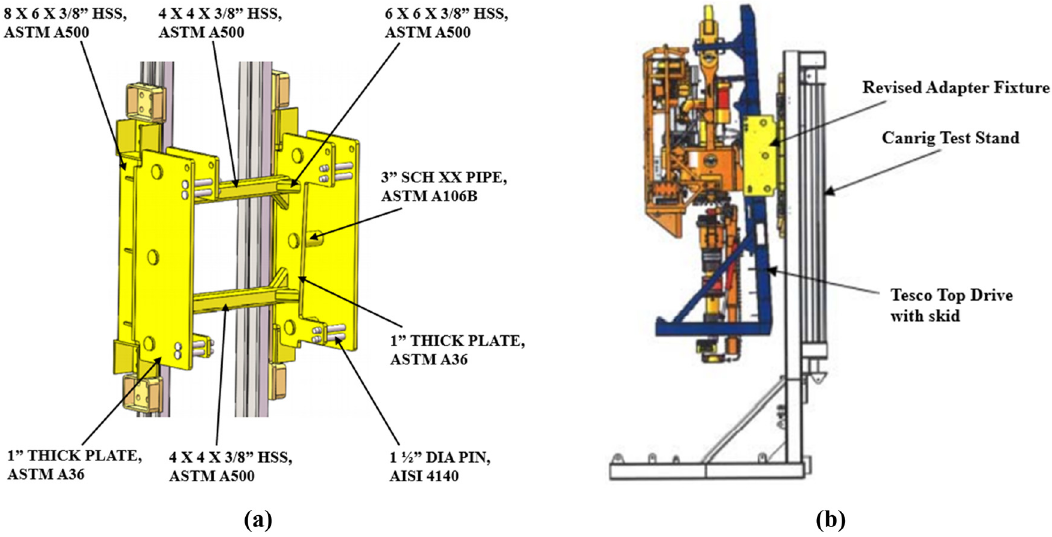
Figure 2: ( a ) The initial design of the fi xture adapter ( yellow ) is mounted on a guide runner ( gray ) . ( b ) Fixture adapter with Tesco top drive is test fi tted onto Canrig test stand.